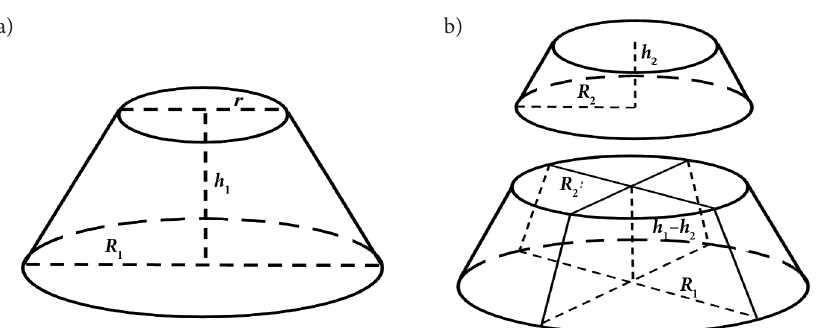
Figure 2. Truncated cone and its volume division into five equal